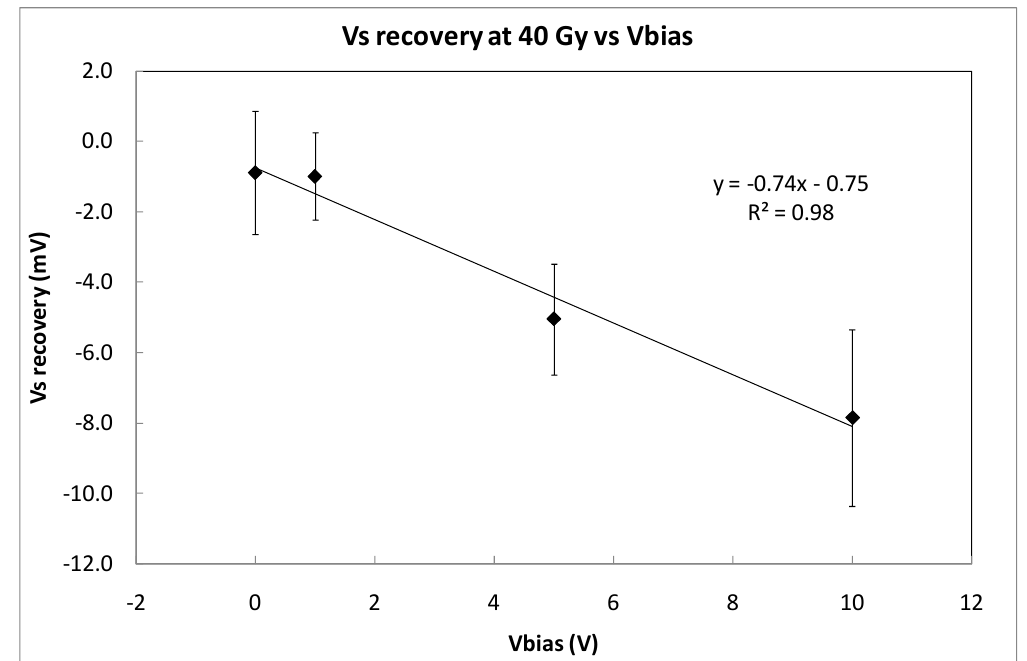
Figure 8. Fading quantified as the difference between the value of Vs at the end of the irradiation at 40 Gy and the value of the source voltage 5 min later. The coverage factor is k = 1. The symbols represents experimental data and the line indicates linear fitting.